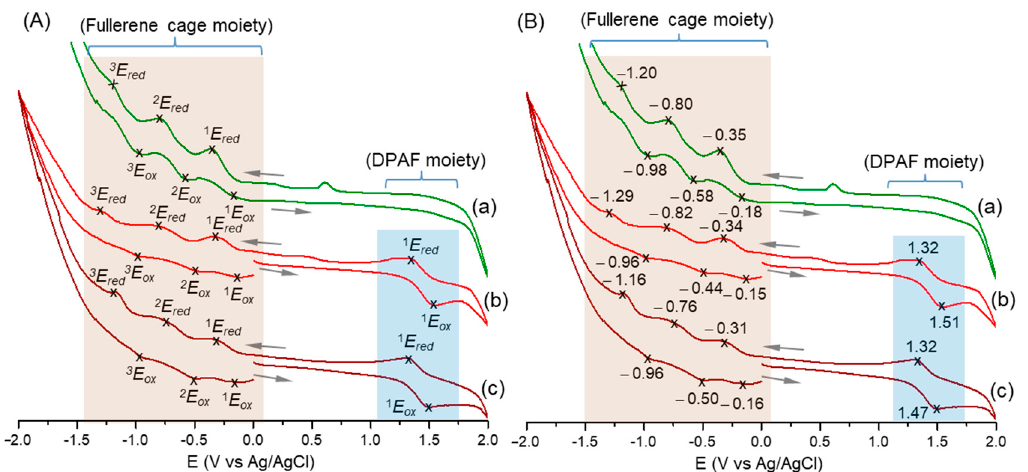
Figure 5. Cyclic voltammograms (CV) of (a) C 60 (> t -Bu-malonate) 2 , (b) cis - cup -tris[(DPAF-C 2M )- C 60 (>DPAF-C 9 )], and (c) C 60 ( > DPAF-C 9 ), where ( A ) displays the sequential redox cycles of each compound with the assignments and ( B ) shows the corresponding potential voltage values at either the peak maximum or minimum of each redox cycle. All solutions were in a concentration of 5.0 × 10 − 3 M in CH 2 Cl 2 using ( n -butyl) 4 N + -PF 6 − as the electrolyte (0.1 M), Pt as working and counter electrodes, and Ag/AgCl as the reference electrode at a scan rate of 10 mV/s.